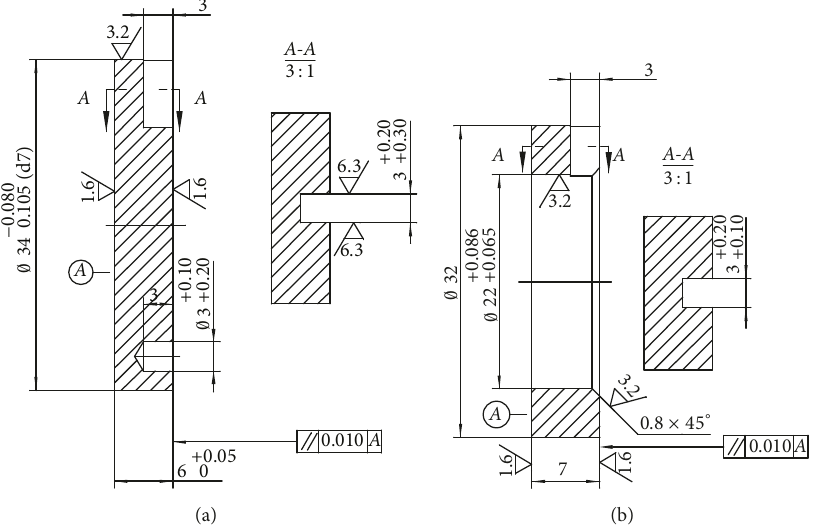
Figure 3: Dimensions of wear tests specimen: (a) disc and (b) ring.